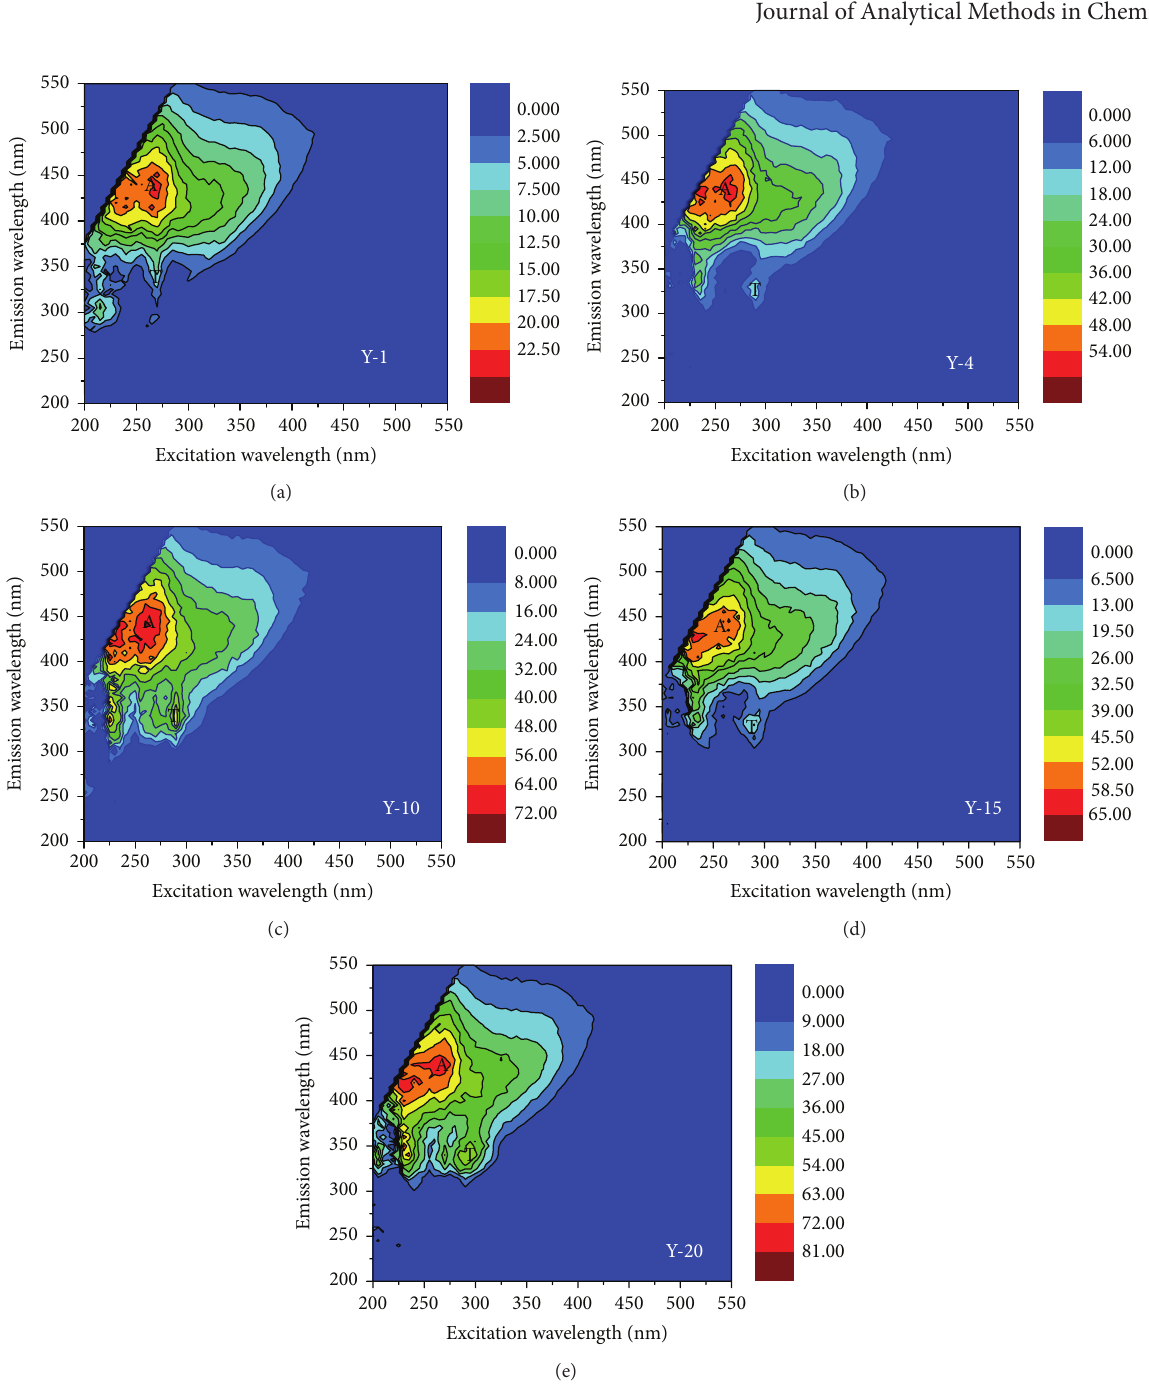
Figure 3: EEM fluorescence contour profiles of the five sites’